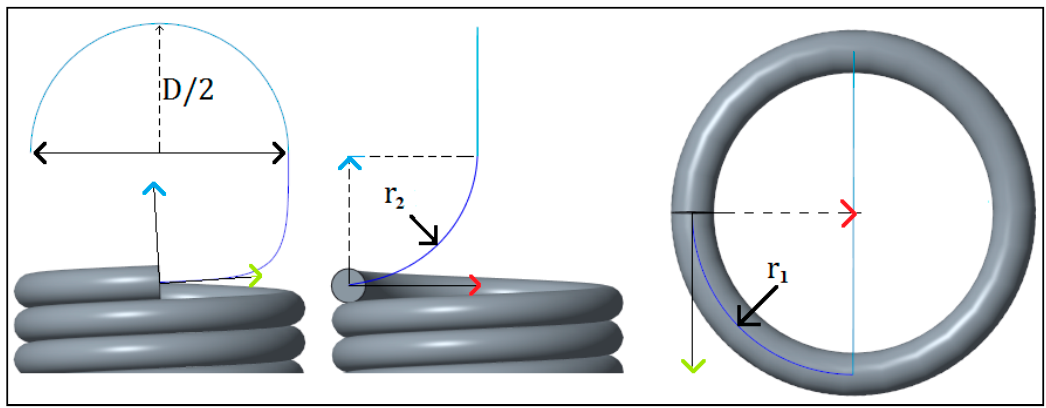
Figure 5. CAD modeling parameters for hook’s arc.